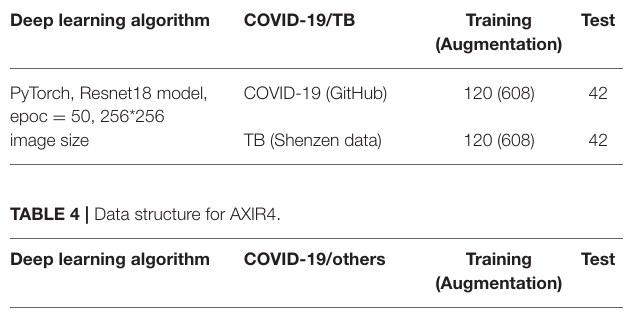
TABLE 3 | Data structure for AXIR3.